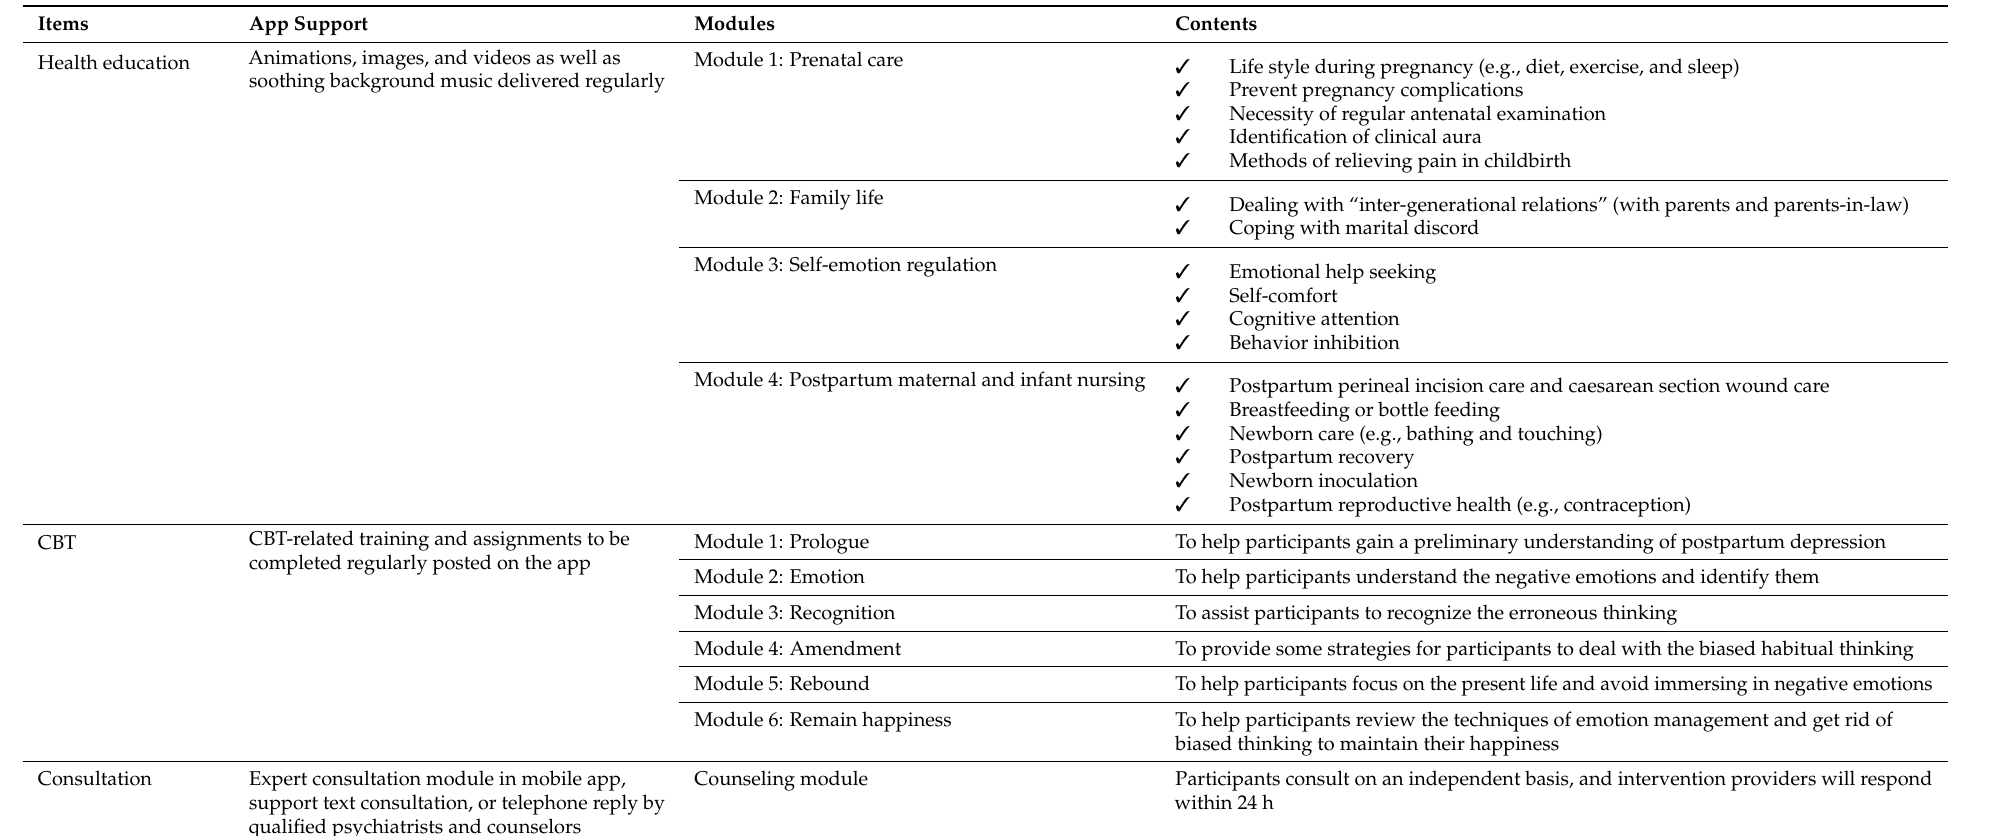
Table 1. Intervention components of the